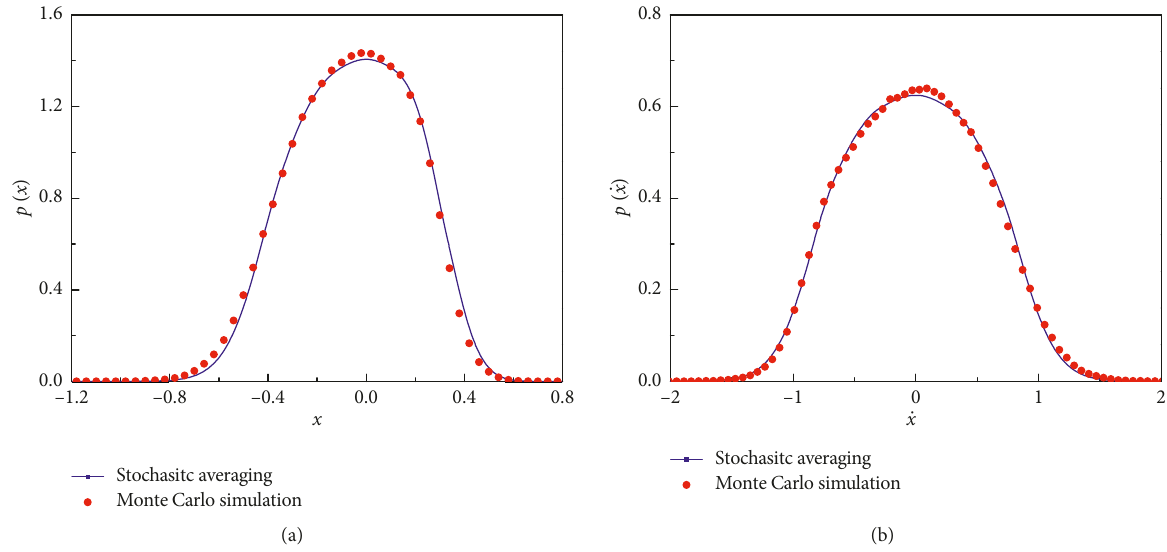
F IGURE 3: The marginal probability densities of system responses. (a) The probability density of displacement X ; (b) the probability density of velocity _ X